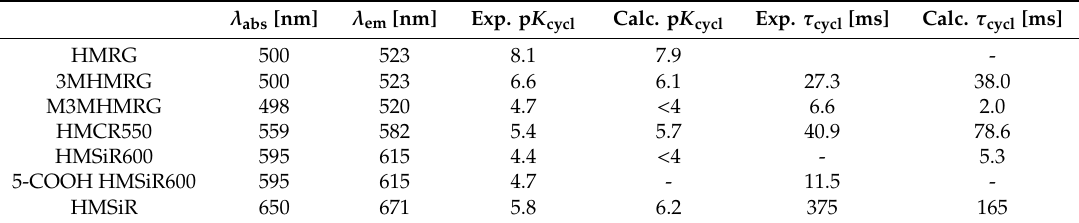
Table 3. Photophysical properties of spontaneously blinking fluorophores with calculated and experimental